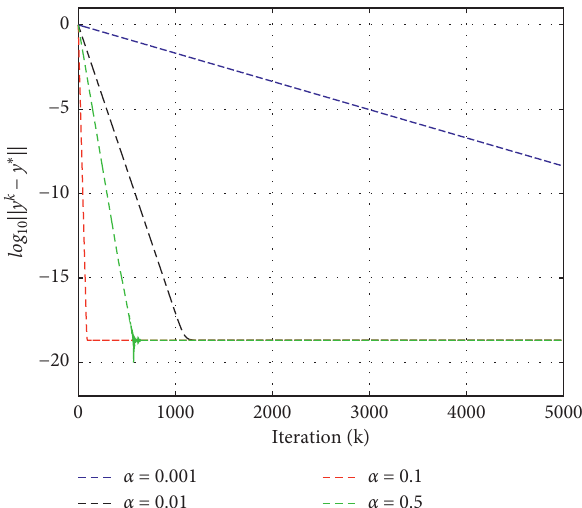
Figure 2: Convergence of log ‖ y k − y ∗ ‖ using different constant 10 step sizes in the gradient method with primal decomposition. The figure shows that slow convergence for relatively small step sizes. Figure 3: Convergence of the residuals ‖ y k − y ∗ ‖ for different dimensions of y when the primal problem (39) is solved using the gradient method followed by primal decomposition. The figure shows that ‖ y k − y ∗ ‖ ⟶ 0 as the iteration number increases. This shows that the convergence of y k to y ∗ is guaranteed even for high dimensional complicating